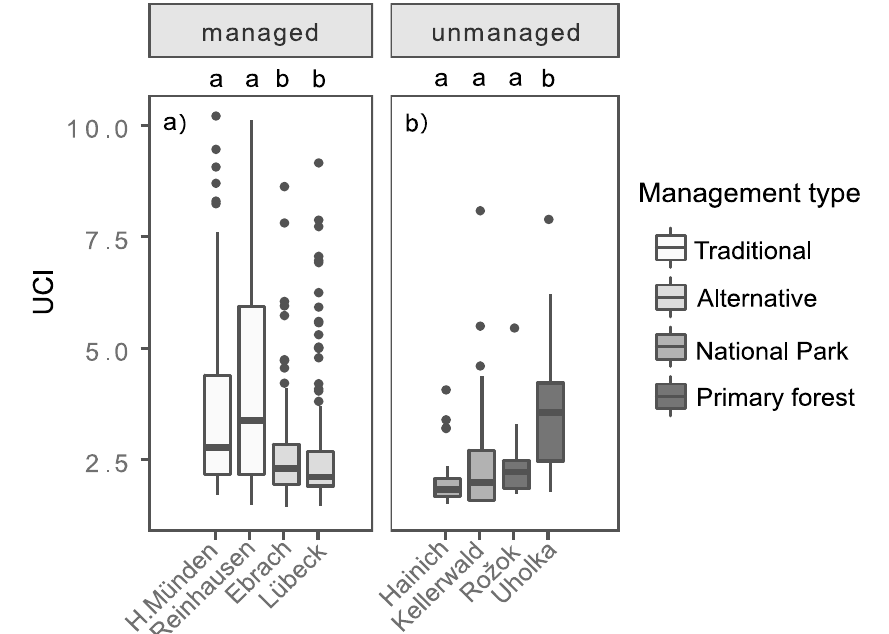
Figure 6. ( a ) Box-and-whisker plots showing the understory complexity index (UCI) values for all managed study sites. The letters a and b indicate significant differences between the traditionally managed and the alternatively managed study sites at p < 0.05. Sample size for managed study sites: Hann. Münden (n = 120), Reinhausen (n = 120), Ebrach (n = 120), and Lübeck (n = 120). ( b ) Box-and-whisker plots showing the understory complexity index (UCI) values for all unmanaged study sites. The letters a and b indicate significant differences between the study sites of the National parks and the primary forests at p < 0.05. Sample size for unmanaged study sites: Hainich (n = 30), Kellerwald (n = 30), Rožok (n = 30), and Uholka (n = 30). Different colors represent the different management